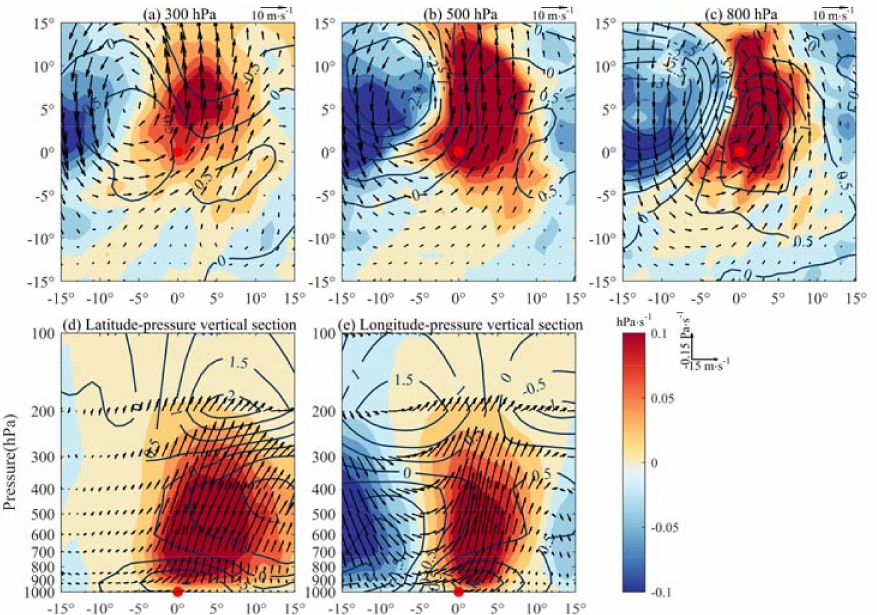
Figure 6. Composite horizontal distributions of wind vectors (black arrows, unit: m/s), wind speed (colored shading, unit: m/s), and temperature anomaly (black contours, unit: K) at the 300 hPa ( a ), 500 hPa ( b ) and 850 hPa ( c ), respectively, under the cyclone centered coordinate, and composite vertical sections of wind vectors (black arrows, horizontal speed unit: m/s; vertical speed unit: − 1 hPa/s), vertical wind speed (color shading, unit: − 1 hPa/s), and temperature anomaly (black contours, unit: K) along the 0 ◦ latitude ( d ) and 0 ◦ longitude ( e ) in the cyclone centered coordinate based on the selected cyclones in the Northwest Atlantic. The red spot is the center of the extratropical cyclone at the sea